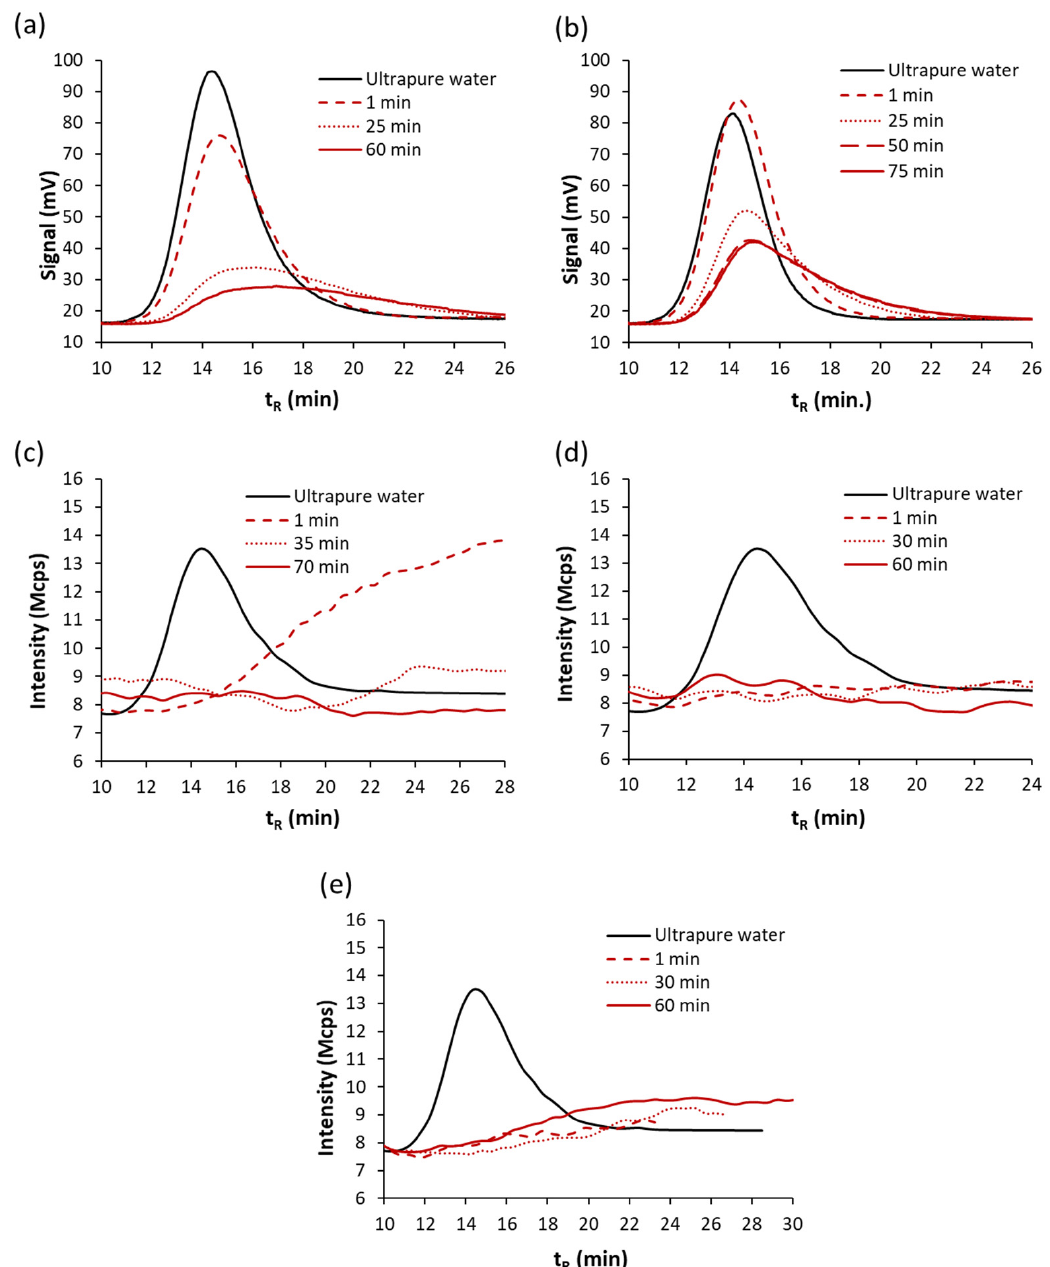
Figure 5. Fractograms ( λ = 395 nm) obtained for suspensions diluted 1/4 of batches O2 ( a ) and O1 ( b ) with BW2 water at different times and batch O2 with water bottled water (BW1) ( c ), tap water (TW) ( d ) and sea water (SW) ( e ) at different times using the DLS detector.